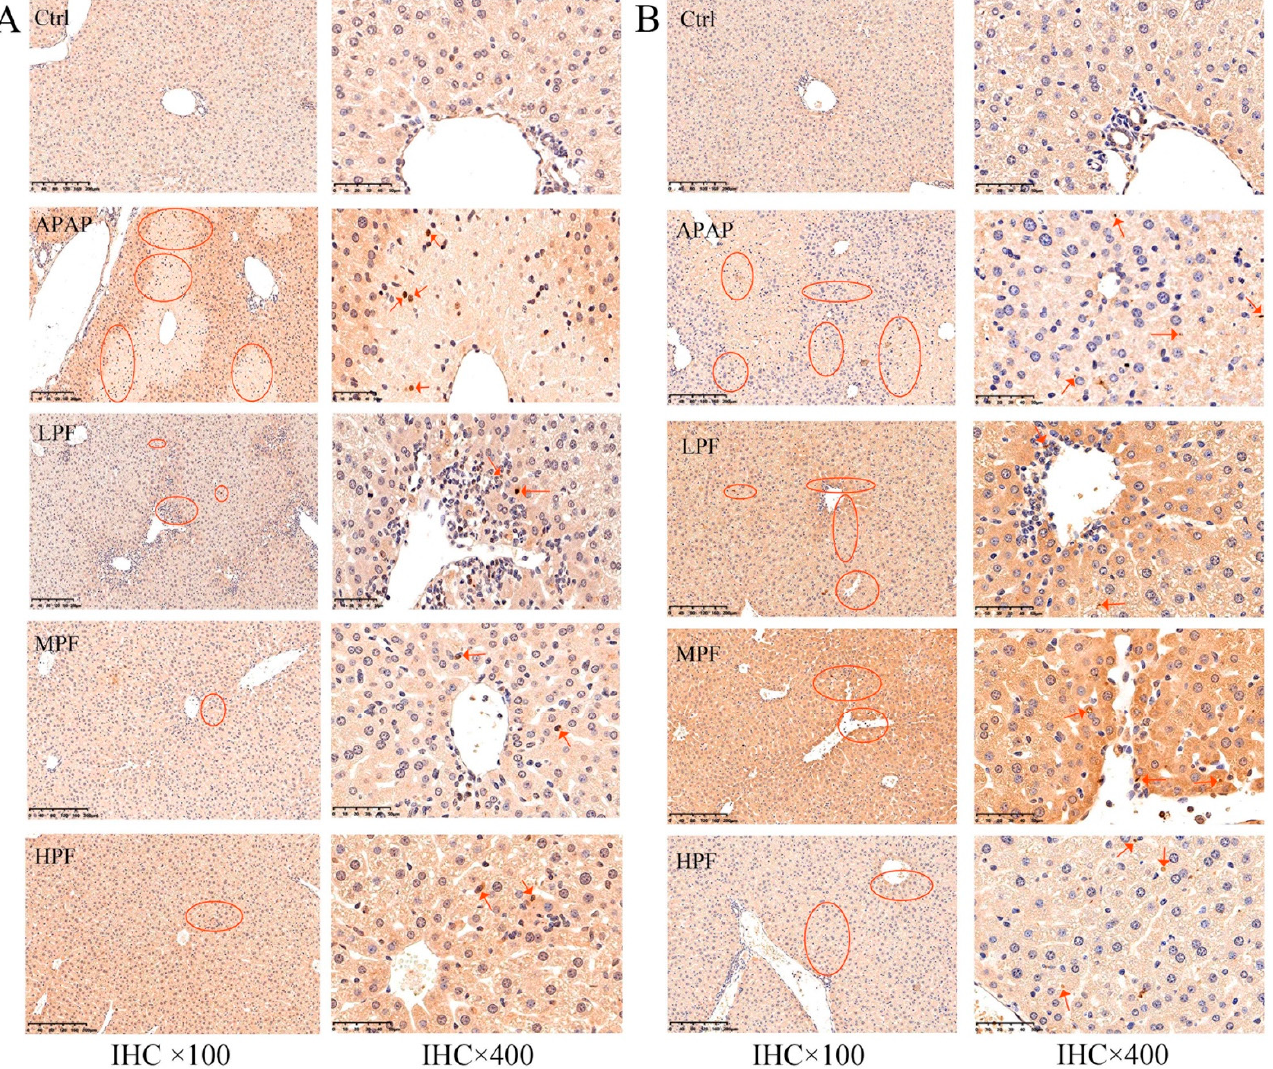
Figure 7. Expression of caspase-9 and caspase-3 was detected using IHC. ( A ) Expression of caspase-9 in different groups. ( B ) Expression of caspase-3 in different groups. The arrow points to the region of elevated protein expression, and the circles points to the area of elevated protein expression. (n = 3).